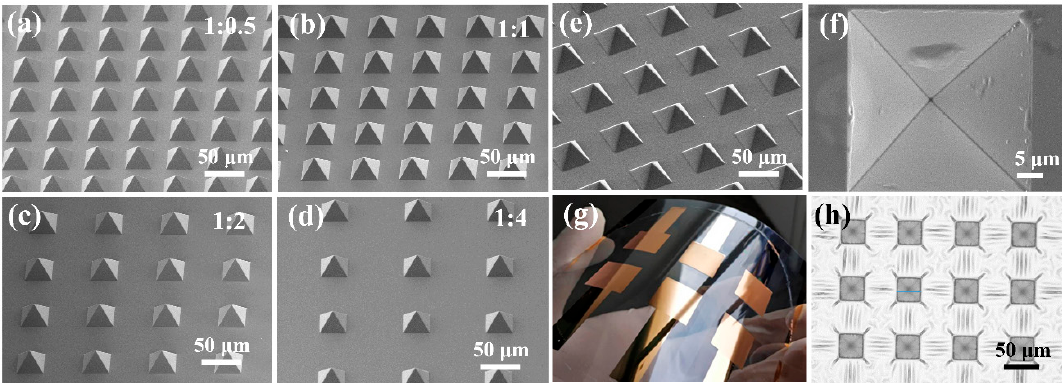
Figure 4. SEM images of a PDMS pyramid array with duty ratio of ( a ) 1:0.5, ( b ) 1:1, ( c ) 1:2, and ( d ) 1:4, ( e ) SEM image of the PDMS pyramid coated with Ti/Au, ( f ) a detailed image of the Ti/Au coated PDMS pyramid, indicating that the metal film deposited on PDMS structures uniformly without cracks or wrinkles, ( g ) the fabricated device bent by hand, ( h ) photo image of the wrinkles on the PDMS pyramid array coated with Ti/Au when there is no PET backup during metal deposition.